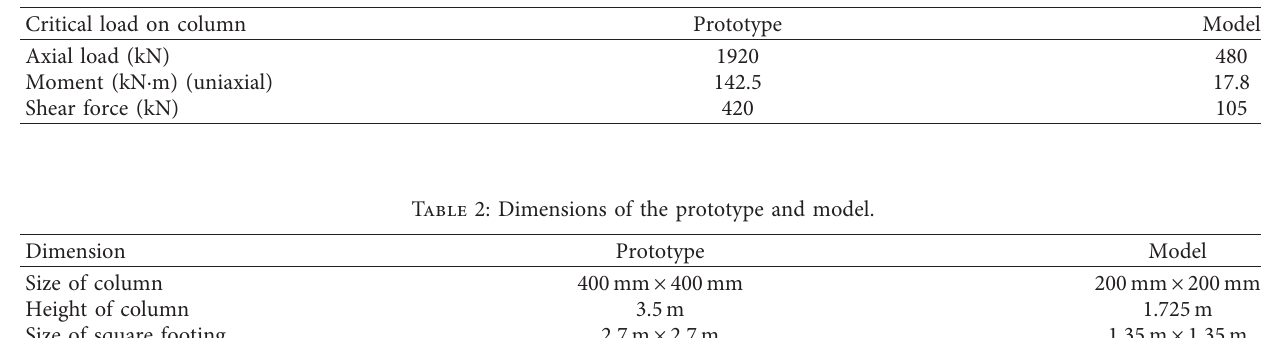
Figure 2: 3-Dimensional view of the model. All dimensions are in m. Table 1: Critical load on column.